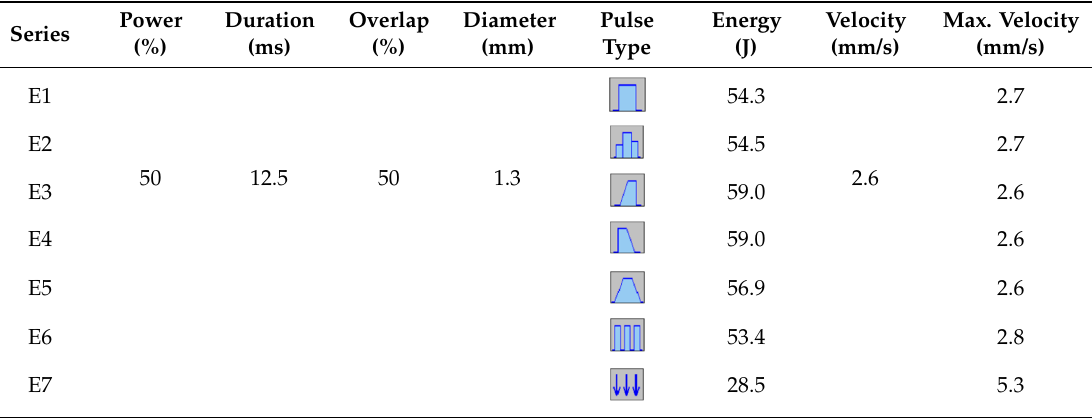
Table A5. Experimental plan for the effects of pulse type on weld penetration.